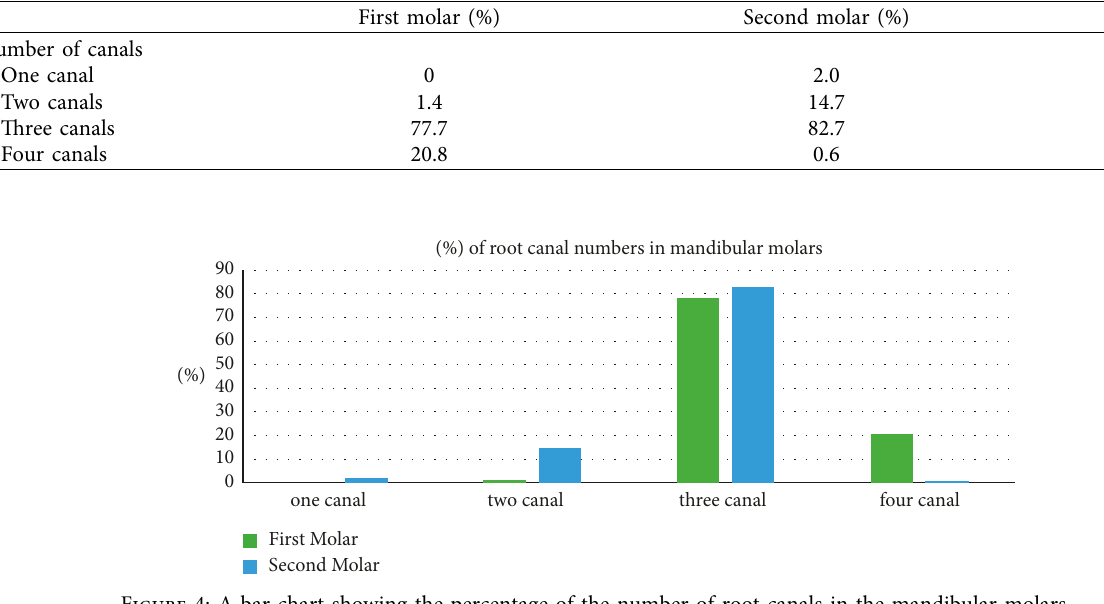
Figure 4: A bar chart showing the percentage of the number of root canals in the mandibular